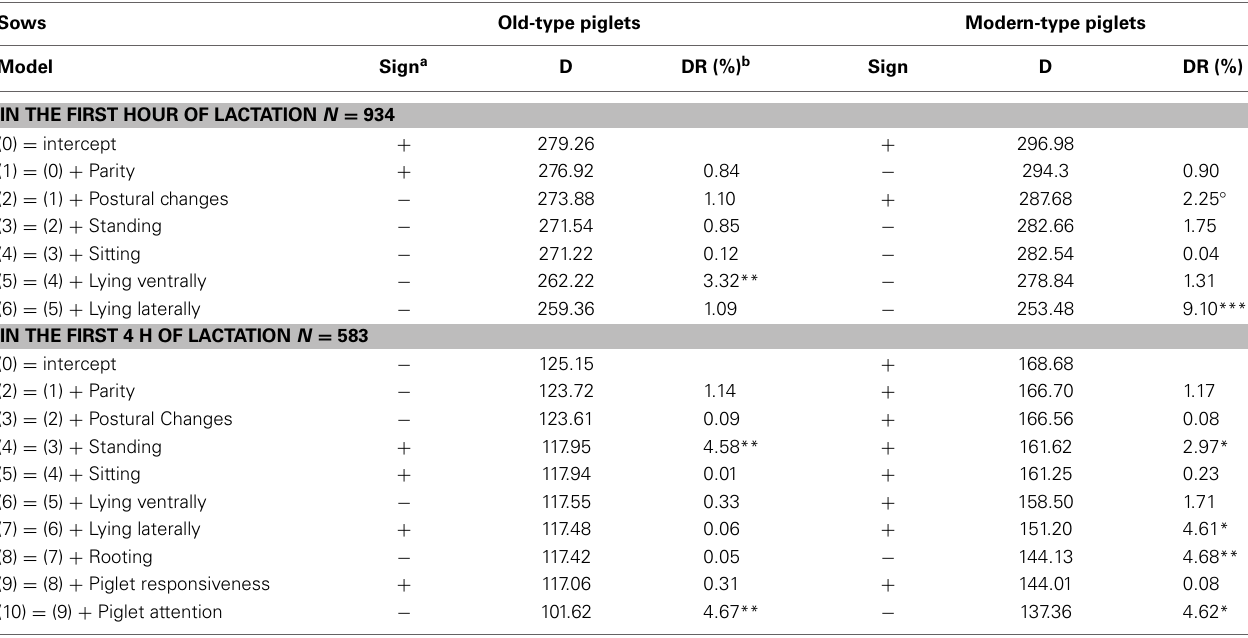
Table 7 | Association between probability of stillbirth and sow